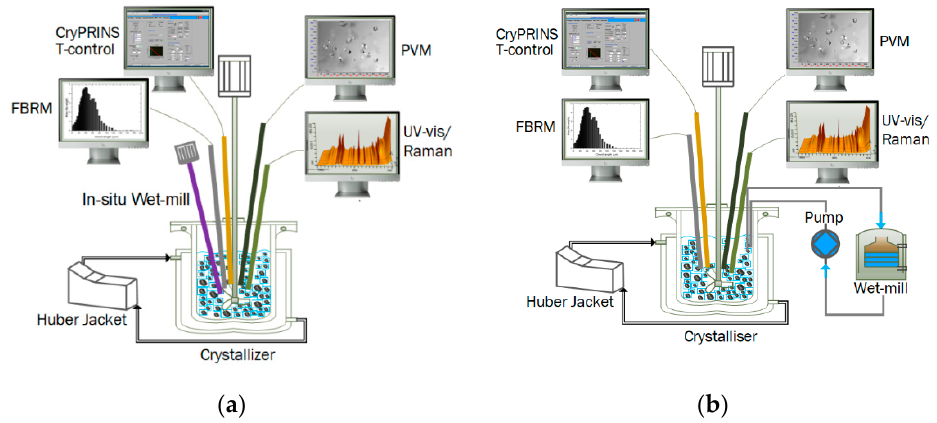
Figure 1. Schematic of the experimental set-up for ( a ) the in situ wet-mill crystallization unit and ( b ) external wet-mill crystallization with recirculation.